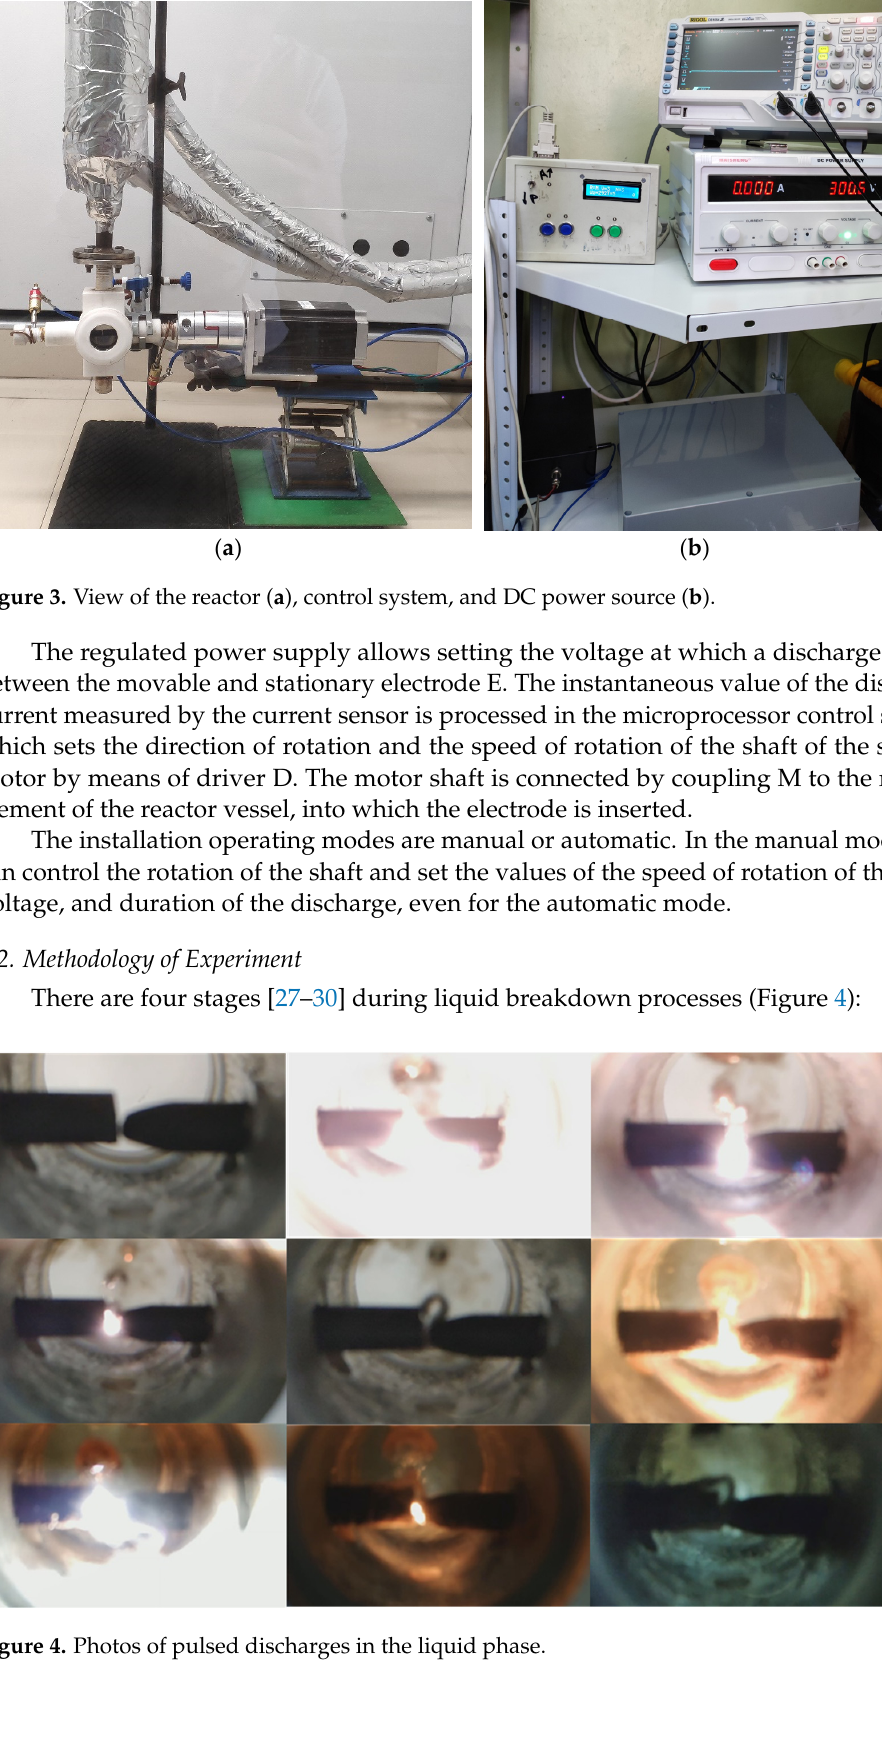
Figure 2. Block diagram of a duration control electric discharges algorithm.